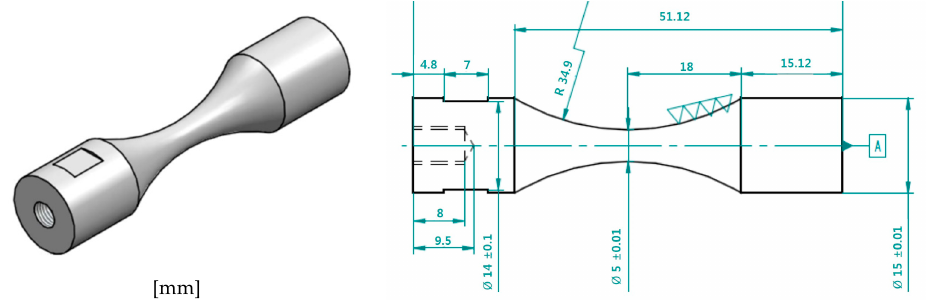
Figure 4. The shape of the fatigue specimen of 4340M steel manufactured considering the dynamic elastic modulus and density.